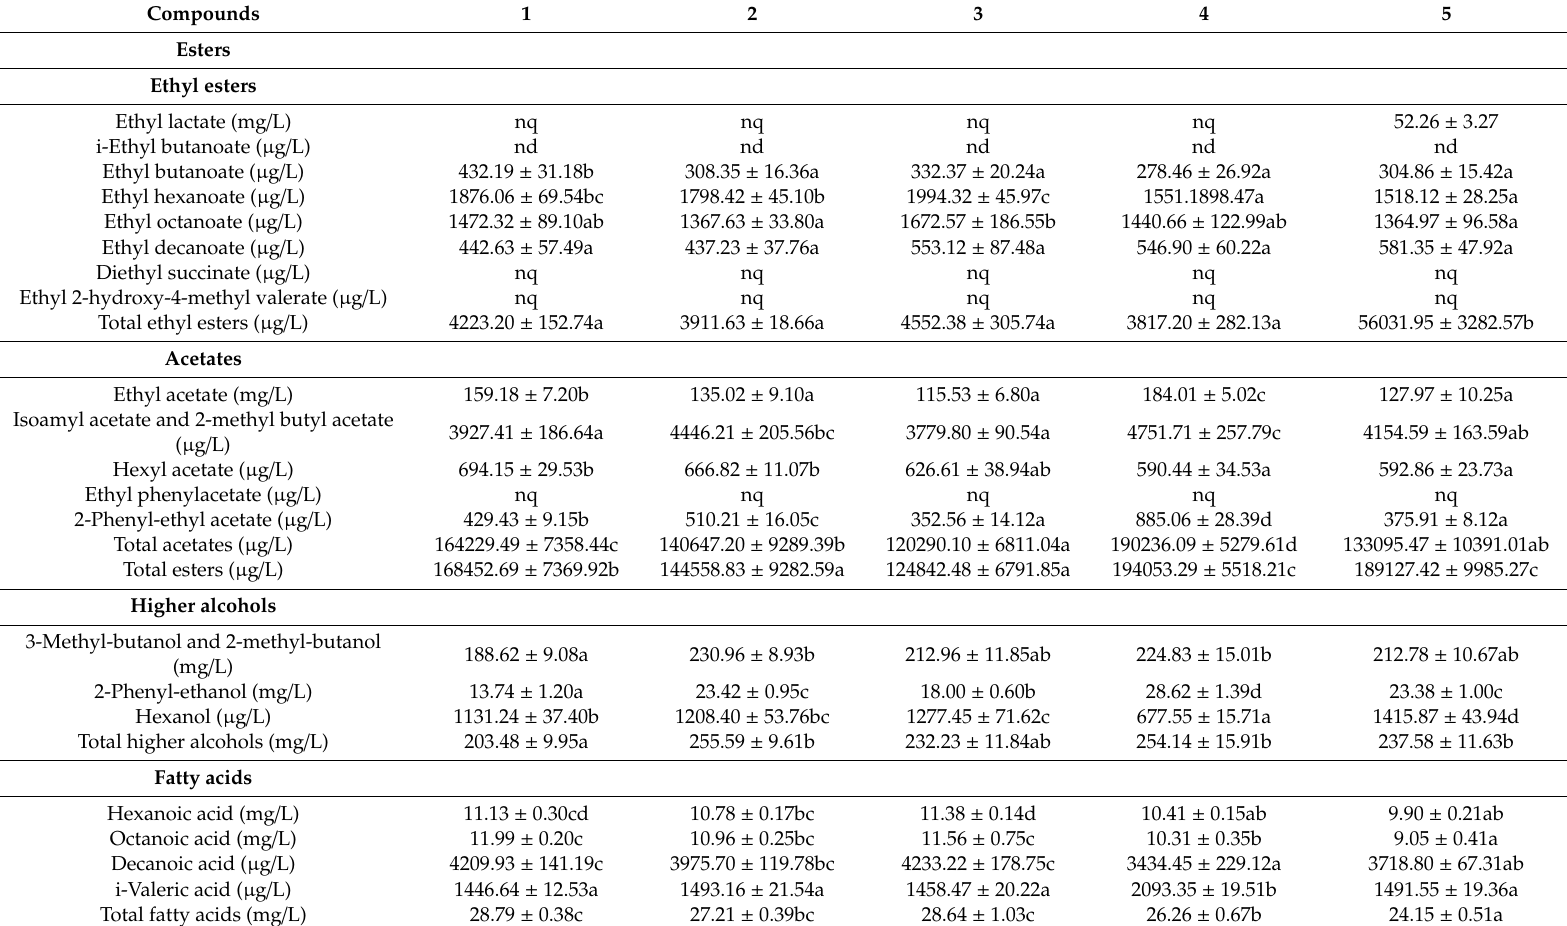
Table 2. Volatile compounds measured after alcoholic fermentations of S. cerevisiae Level 2 ® (1), and sequential fermentations with S. cerevisiae Level 2 ® and